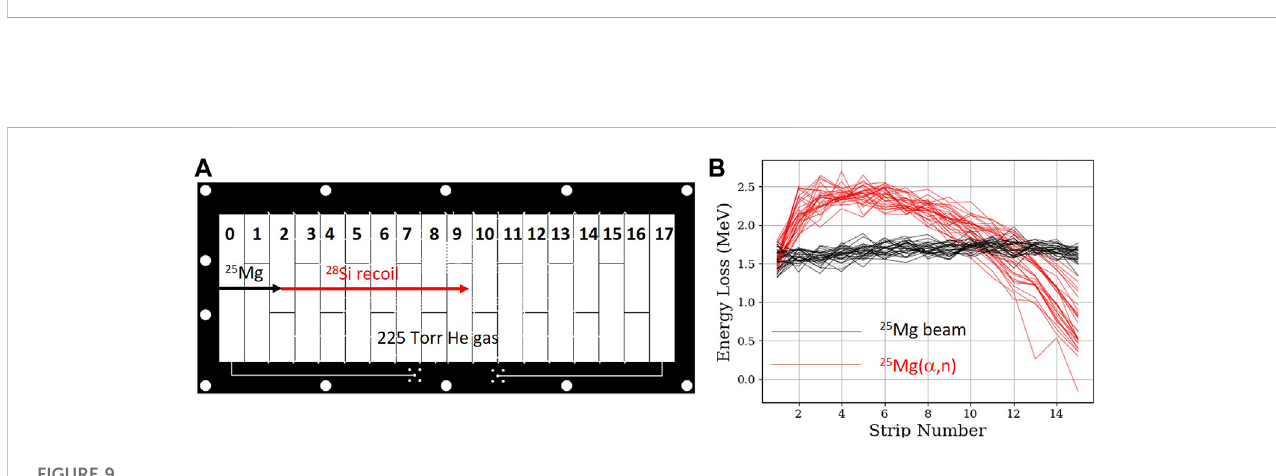
FIGURE 8 (A) ThewindowlessgastargetRhino.Thebeamentersfromtheleftthroughaseriesofpumpingaperturesenteringatargetchamber fi lledwith10Torrof targetgas.Silicondetectorsdetectchargedparticlesfromproducednuclearreactions. (B) Thechargedparticlespectrumfrom 4 He+Nereactionsobservedat 120 degrees at a bombarding energy of 5.745 MeV.